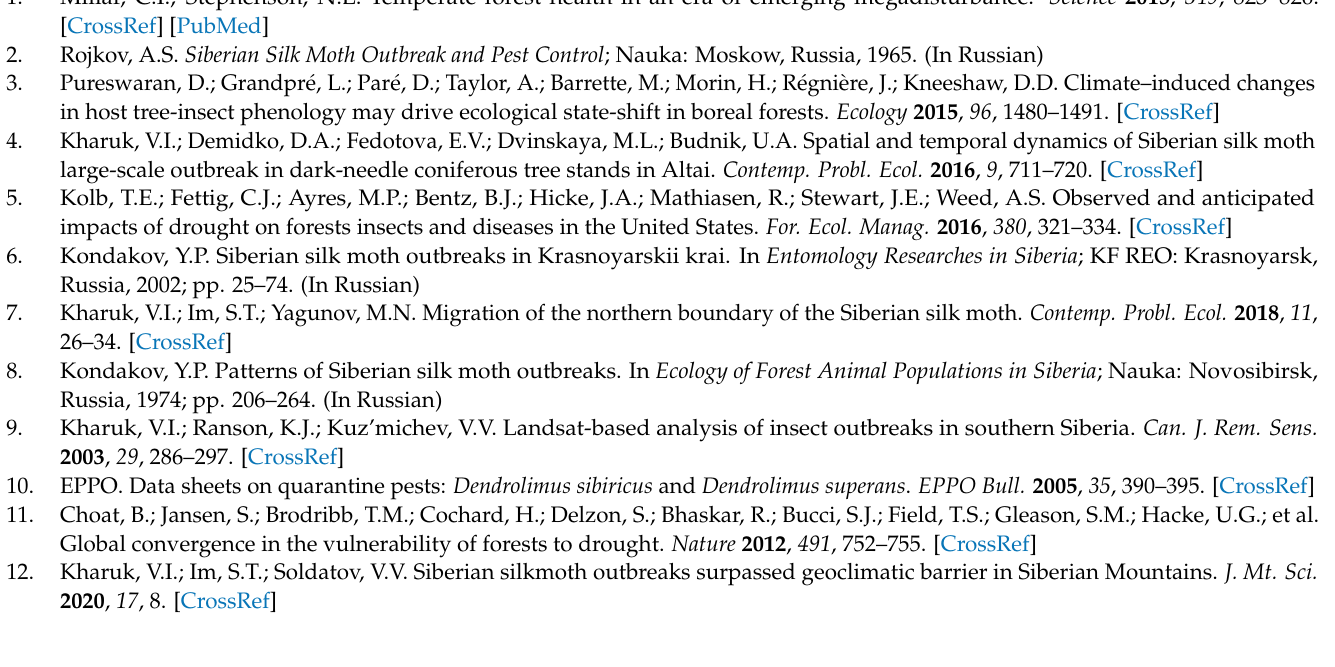
(a) June–July mean temperature, (b) total precipitation and 2-month July SPEI values in the study area; Figure S3: Monthly climatic anomalies from 2012 to 2017 compared with 1981–2010 averages or totals; Figure S4: Positive relationship found between tree age estimated at 1.3 m and the Pearson cor- relation obtained by relating individual, indexed ring-width series vs. mean June–July temperatures; Figure S5: Regime shift analyses of spruce tree growth patterns in the three study